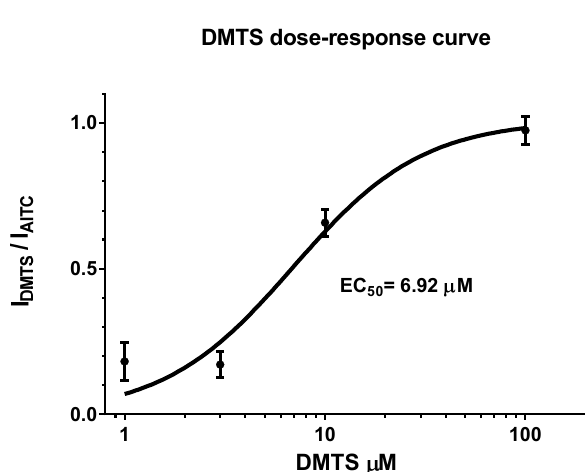
Figure 1. Effects of DMTS on TRPA1 expressed in CHO cells. ( A ) Effects of DMTS (10 µ mol/L) compared to that of AITC (100 µ mol/L). The peak currents are shown at positive voltage (+50 mV). Dotted line indicates zero pA current. Individual current traces are presented as red circles (every second trace is shown). The baseline current (I base ) represents the peak current measured before the addition of DTMS. The horizontal bars above indicate the period of time when the DMTS, AITC, and HC030031 (50 µ mol/L) were applied. ( B ) Representative traces are depicted in this panel. Current increases caused by the activators are presented in blue (DMTS, 10 µ mol/L) and red (AITC, 100 µ mol/L). The effect of the inhibitor is in purple (HC030031 50 µ mol/L). The black trace is the current measured in control, a Ca 2+ -free solution (i.e., baseline current). ( C ) Dose–response curve for DMTS. The vertical axis represents ionic current (I) evoked by DMTS normalized to the current induced by AITC, I DMTS /I AITC = (I DMTS peak-I base )/(IAITC peak-I base ). Solid line indicates the best-fit Hill equation (see methods). The EC50 value was 6.92 µ mol/L; error bars indicate SEM for n = 3 independent experiments; the Hill coefficient was